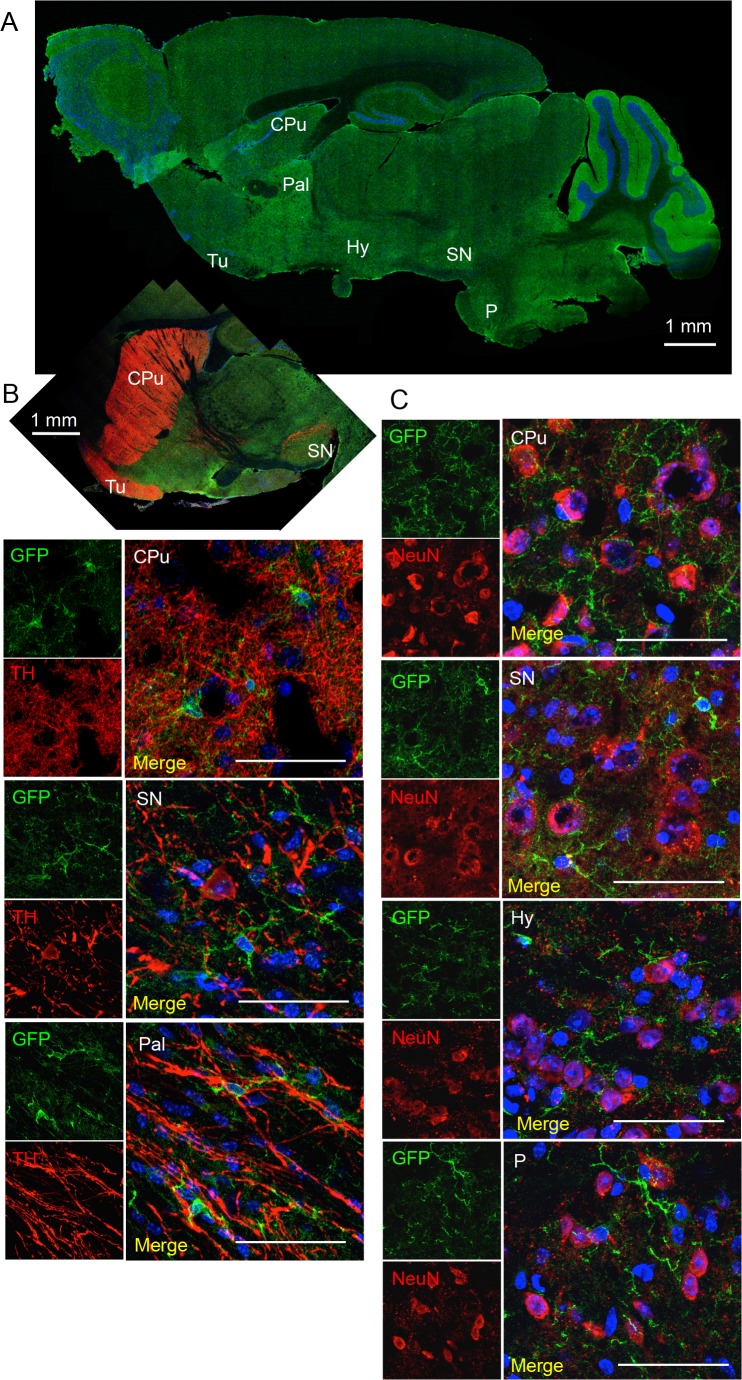
Co-stainings of EGFP (A10262, Thermo Fischer Scientific; ab6556, Abcam) and neuronal markers tyrosine hydroxylase (dopaminergic neurons, (B) and NeuN (C) in the substantia nigra (SN), hypothalamus (Hy) and pons (P).CPu, caudate putamen; Tu, olfactory tubercle). (A) EGFP-staining of sagittal brain section to indicate regions shown in B and C. Scale bars: 50 μm or as indicated. DAPI staining in blue (n = 3 animals).